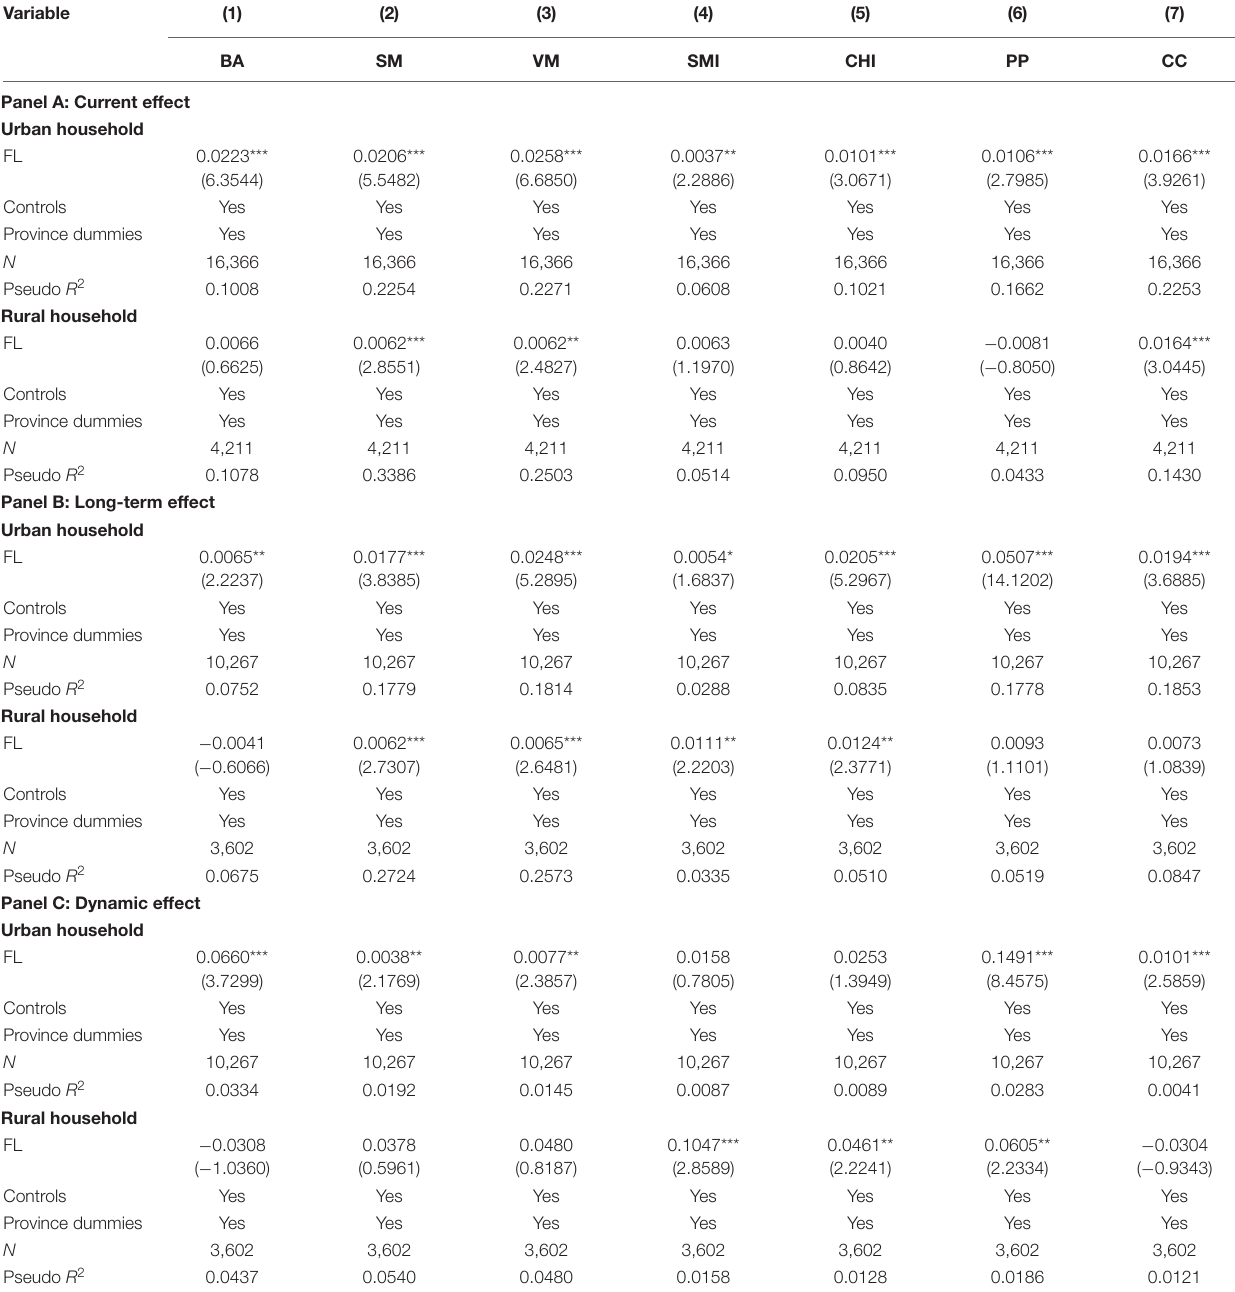
TABLE 15 | Urban and rural heterogeneity